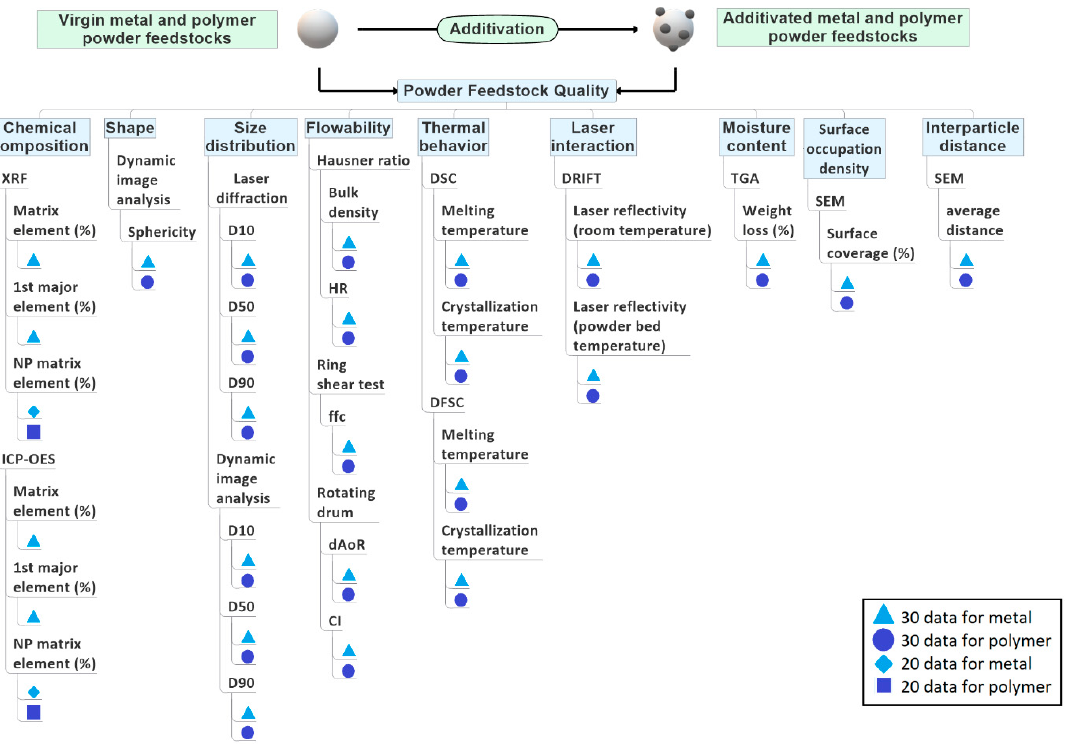
Figure 4. The material properties of powder feedstocks affected by nanoparticles recommended test methods to measure each material property for 30 metal powder batches and 30 polymer powder batches, and the number of data generated for each property metric. Explanation for abbreviations are as follow: X-ray fluorescence (XRF); inductively coupled plasma-optical emission spectroscopy (ICP-OES); the portion of particles with diameters smaller than this value is 10% (D10); the median diameter (D50); the portion of particles with diameters below this value is 90% (D90); hausner ratio (HR); consolidation stress/unconfined yield strength (ffc); dynamic angle of repose (dAoR); cohesive index (CI); differential scanning calorimetry (DSC), differential fast scanning calorimetry (DFSC); diffuse reflectance infrared fourier transform (DRIFT); thermogravimetric analysis (TGA); scanning electron microscope